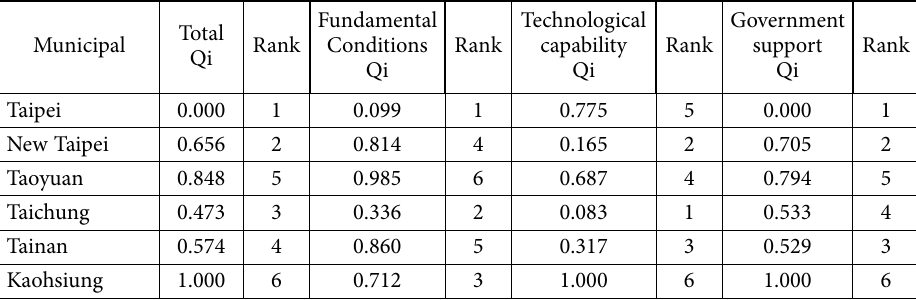
Table 8. Innovation and technology capabilities for the six metropolitan areas-10 University Scholars